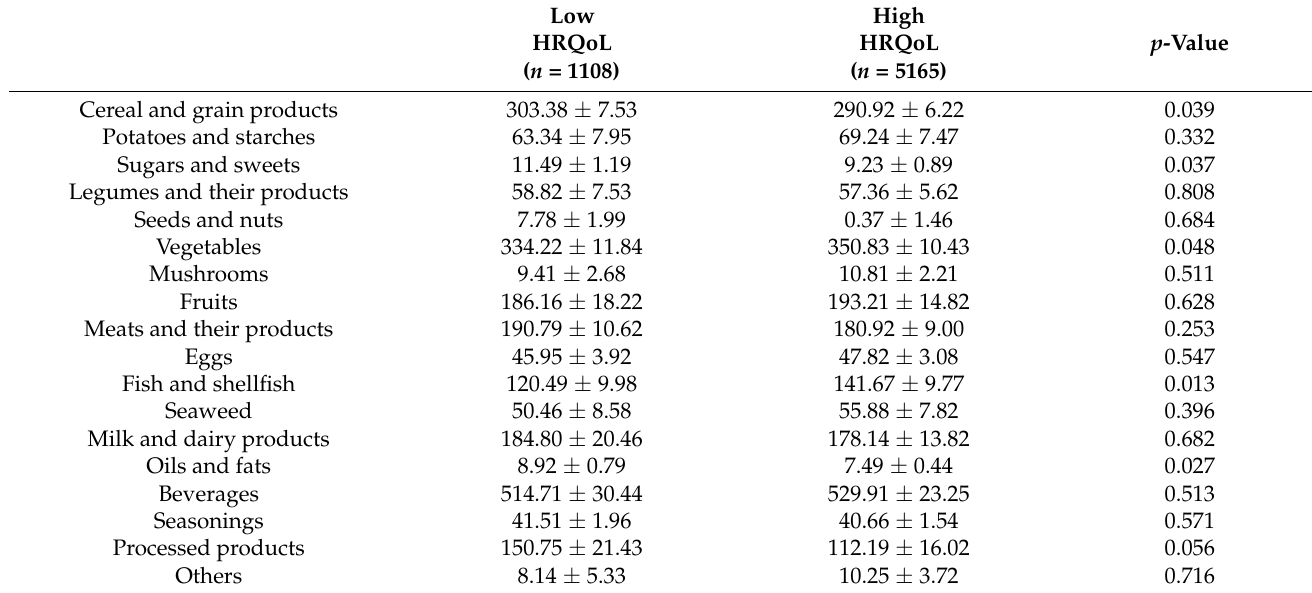
Table 2. Food group intakes of males according to HRQoL among Korean adults ( n = 6273).